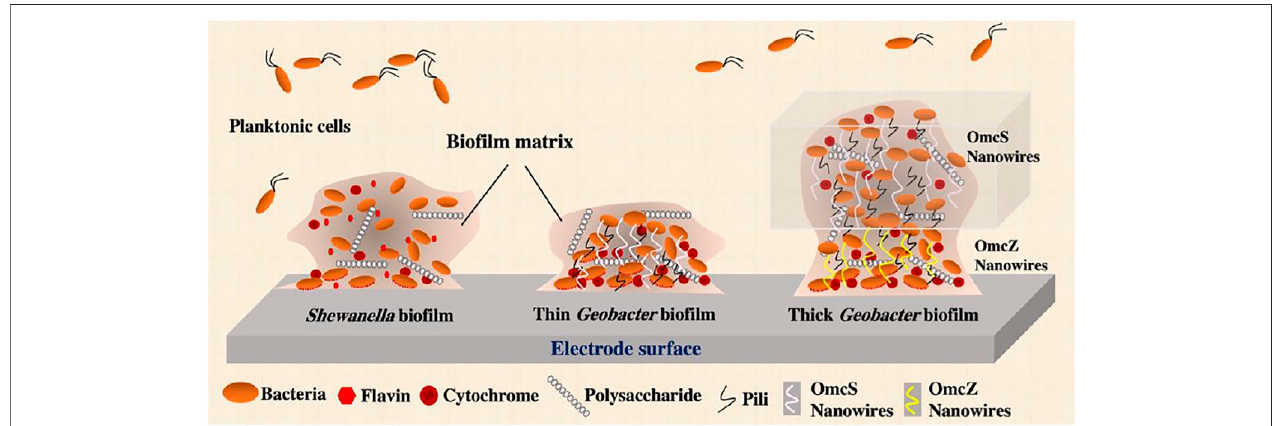
FIGURE 2| The complex structure of Shewanella and Geobacter bio fi lms in abioelectrochemical system. Microcolonies in the mature bio fi lm are characterized by anextracellularpolymericsubstances (EPS)matrixconsistingofpolysaccharides, proteinsandextracellularDNA(eDNA).Differentfromthatofnonelectrogenicbacteria, thebio fi lmmatrixofexoelectrogensiselectricallyconductiveandcontainsextracellularelectrontransfercomponents,suchascytochromesandotherelectronmediators in Shewanella EPSmatrix,aswellascytochromes,piliandOmcS/OmcZ-basednanowiresin Geobacter EPSmatrix.Becauseofhigherabundanceofcytochromes that form conductive nanowires, Geobacter bio fi lm is much more conductive and thicker than Shewanella bio fi